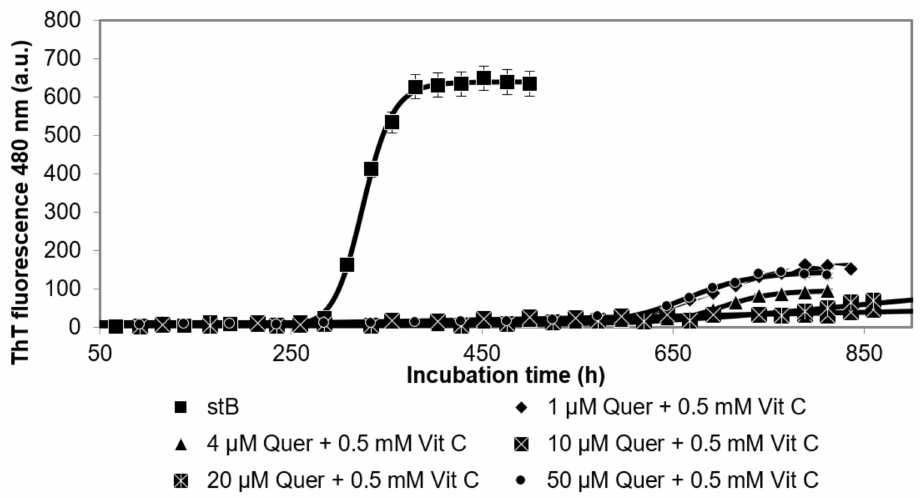
Figure 5. Time course of ThT fluorescence intensity following the amyloid fibril formation of stB in the presence of quercetin (Quer). Different concentrations of Quer (as indicated) were added, while vitC concentration was kept constant at 0.5 mM.